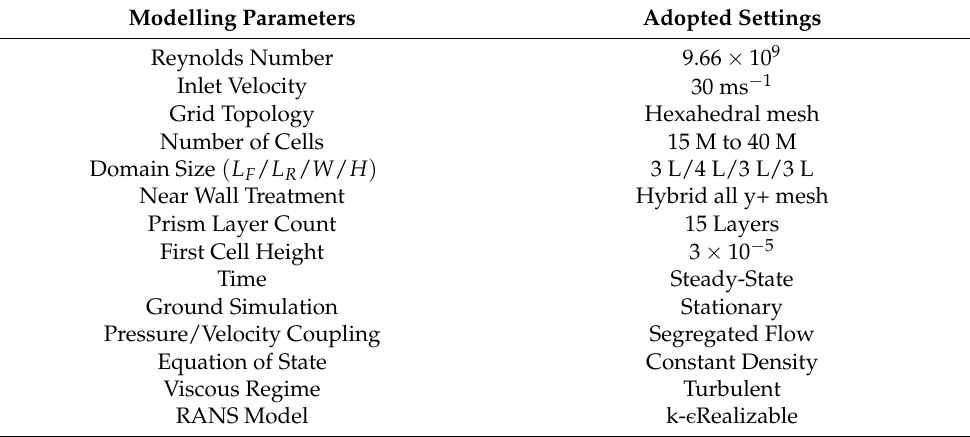
Table 1. Simulation settings for the individual and platoon